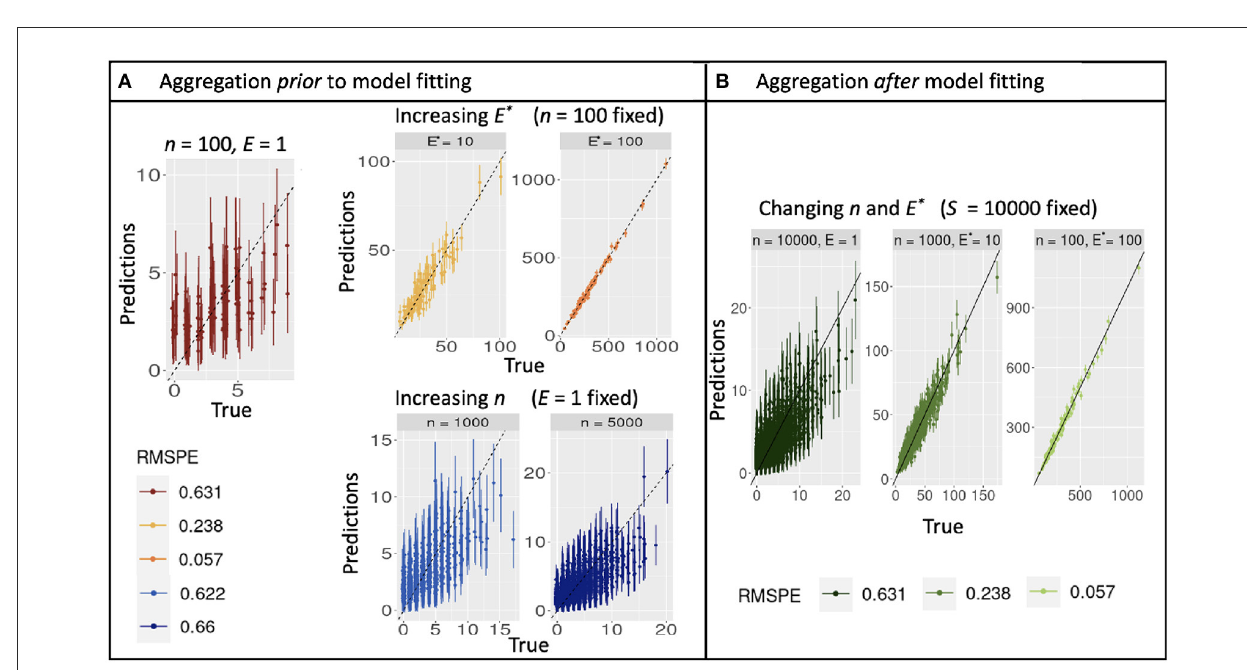
FIGURE3 Out-of-sample true and predicted counts with corresponding root mean square prediction error for simulated data when aggregating before (A) and after (B) model fitting. (A) Increasing observation effort E improves predictions with reduced uncertainty, while increasing sample size n does not. The combination ( n = 100, E = 1) plotted in dark red can be used as reference. (B) Predictions from a model fitted with E = 1 are dominated by noise, but can be rehabilitated by aggregation to E ∗ = 10 or 1,000.